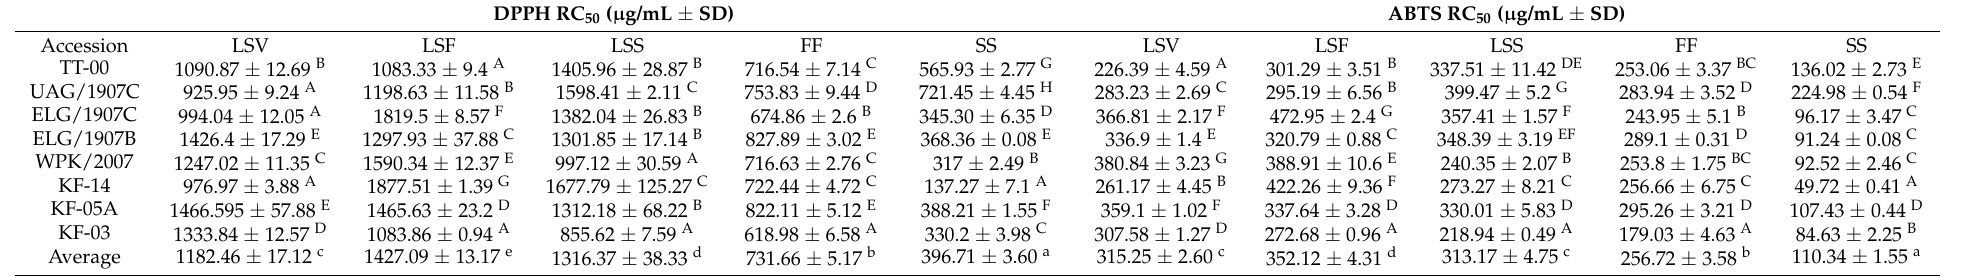
Table 2. Ability to scavenge free radicals expressed as RC 50 values of CG accessions different organ extracts obtained at different growth